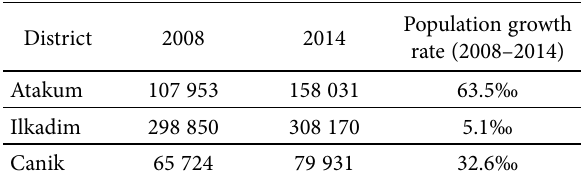
Population growth rate (2008–2014)